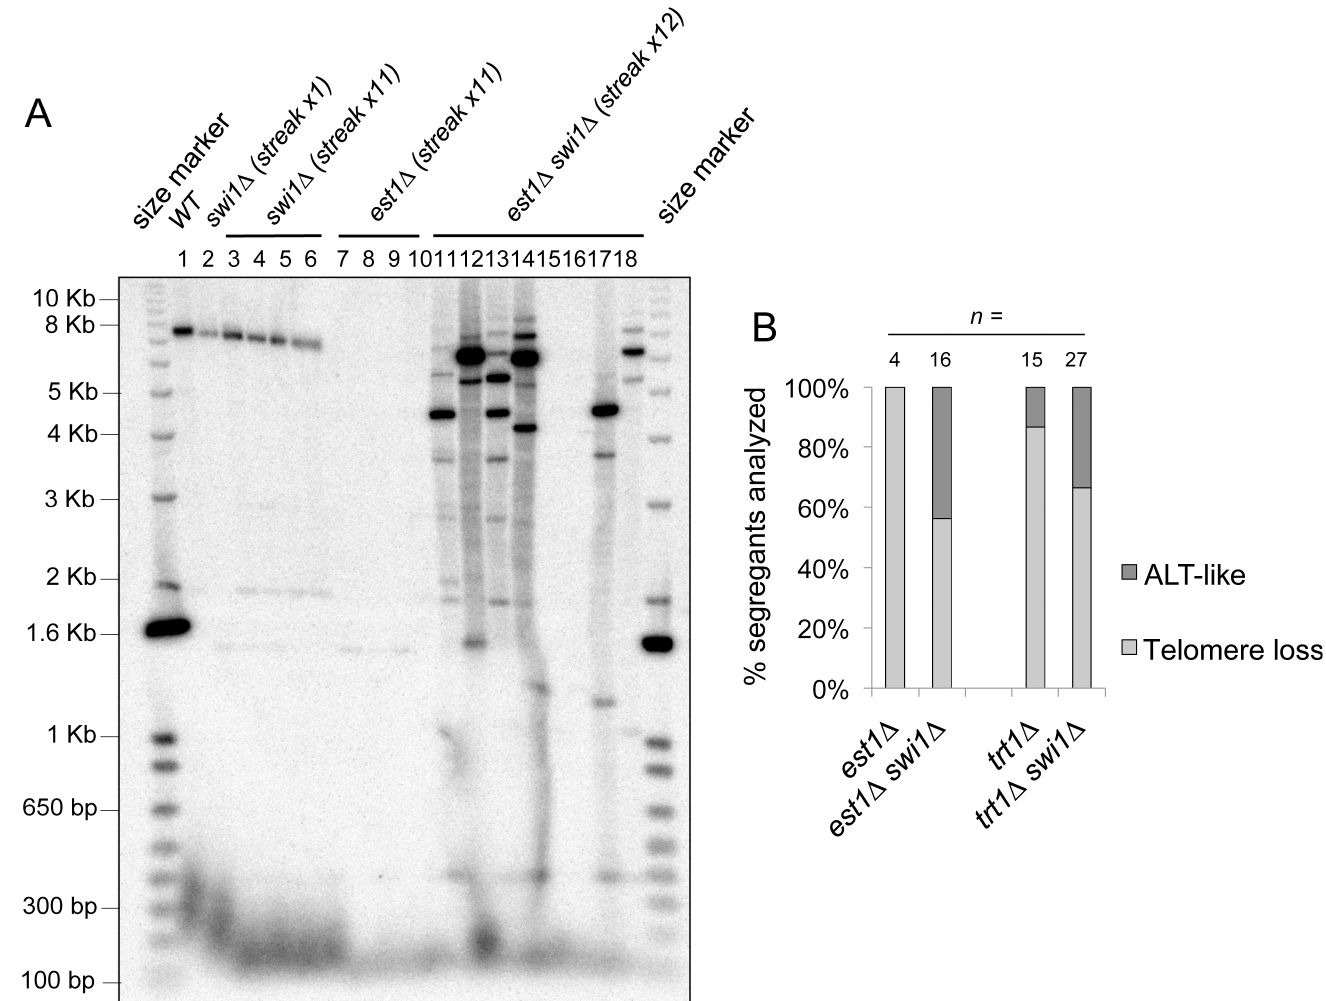
Fig 8. Swi1 is required to prevent hyperrecombination at telomeres and ALT-like telomere phenotypes in the absence of telomerase. (A) swi1 deletion significantly increases the chances of telomerase negative cells to undergo ALT-like telomere maintenance. Representative image of telomere Southern blot analysis of wild-type, swi1 Δ , est1 Δ and est1 Δ swi1 Δ cells. Multiple segregants with the same genotypes were analyzed after at least 11 passages. Apa I-digested DNA was hybridized with the telomere-specific probe as described in Fig 2B. Representative results are shown. (B) Quantification of the independent segregants analyzed for each genotype and classification depending on their telomere